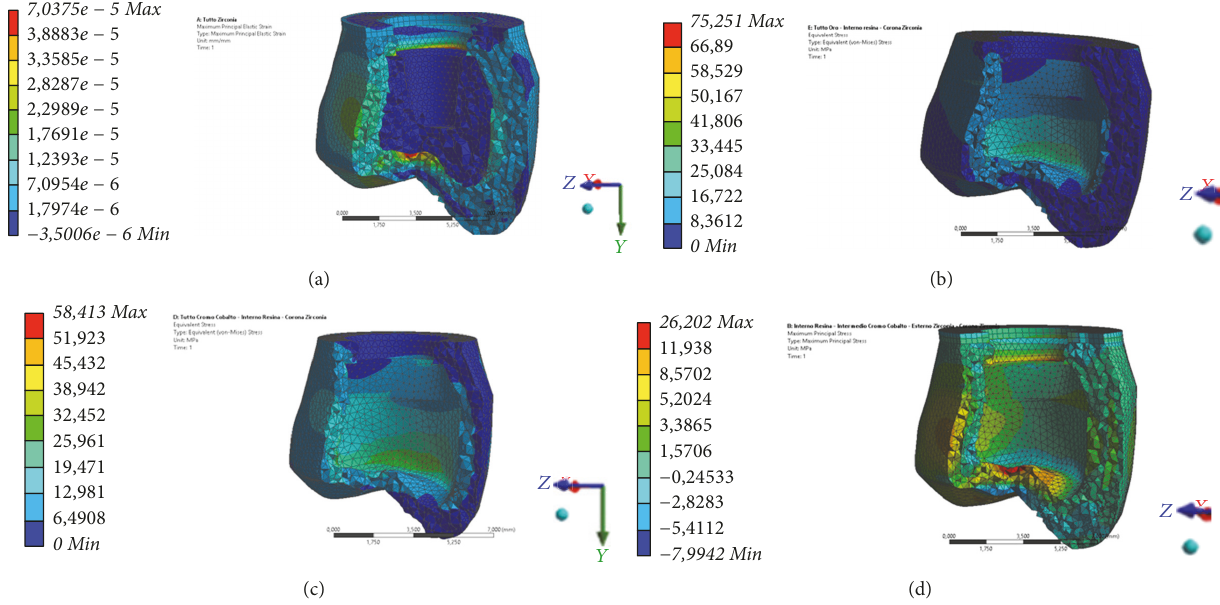
Figure 5: Different colors underline the stress distribution area related to the used material. The chrome cobalt alloy and the zirconium crown seem to better distribute the stress around the crown responding to vertical forces. (a) The zirconia crown distributes the stress in all the crown portions and areas even if a little stress is presented on the occlusal zone. ((b) and (c)) Chrome cobalt alloy and gold alloy guarantee perfect resistance to the fracture and a well distribution of the stress. (d) Dental resins show low resistance on